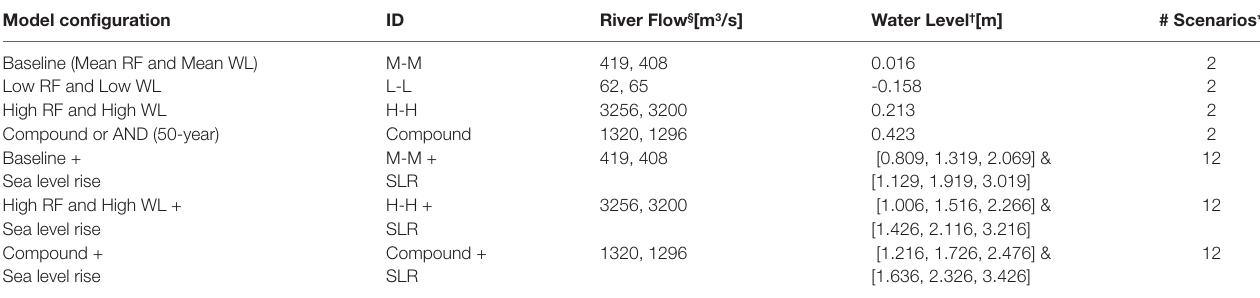
TABLE 3 | Statistical scenarios for hydrodynamic simulation derived from statistical analyses in Mobile Bay, AL. Model configuration